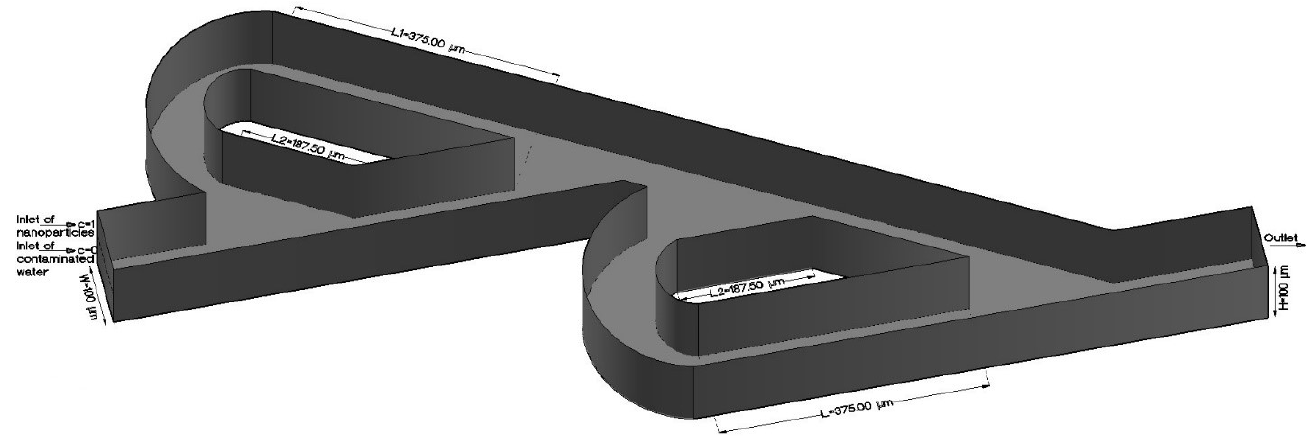
Figure 1. Micromixer geometry and nanoparticles, contaminated water inlets, and outlet flow directions.